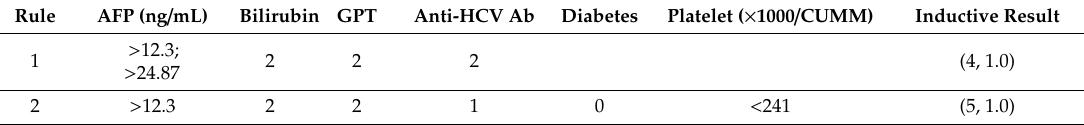
Table 8. Model 1 (with bacterial liver abscess variable) classification results—liver cancer.